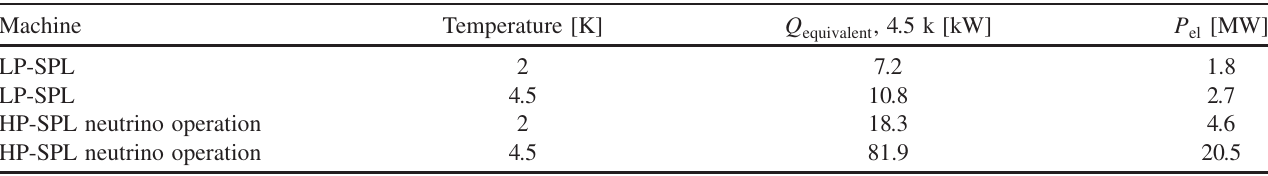
TABLE XVII. Cryogenic plants for 1408.8 MHz, considering a 4 GeV LP-SPL and a 5 GeV HP-SPL.